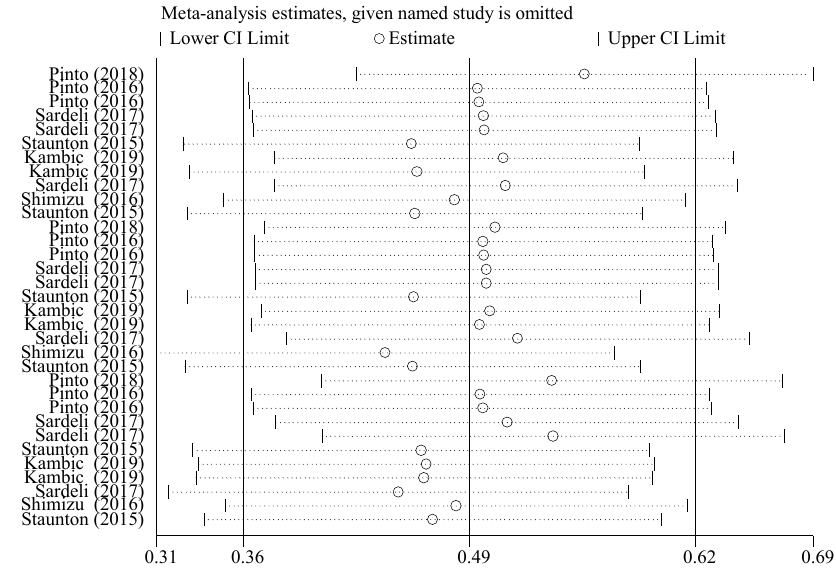
Figure 6. Sensitivity analysis for acute hemodynamic response outcomes.